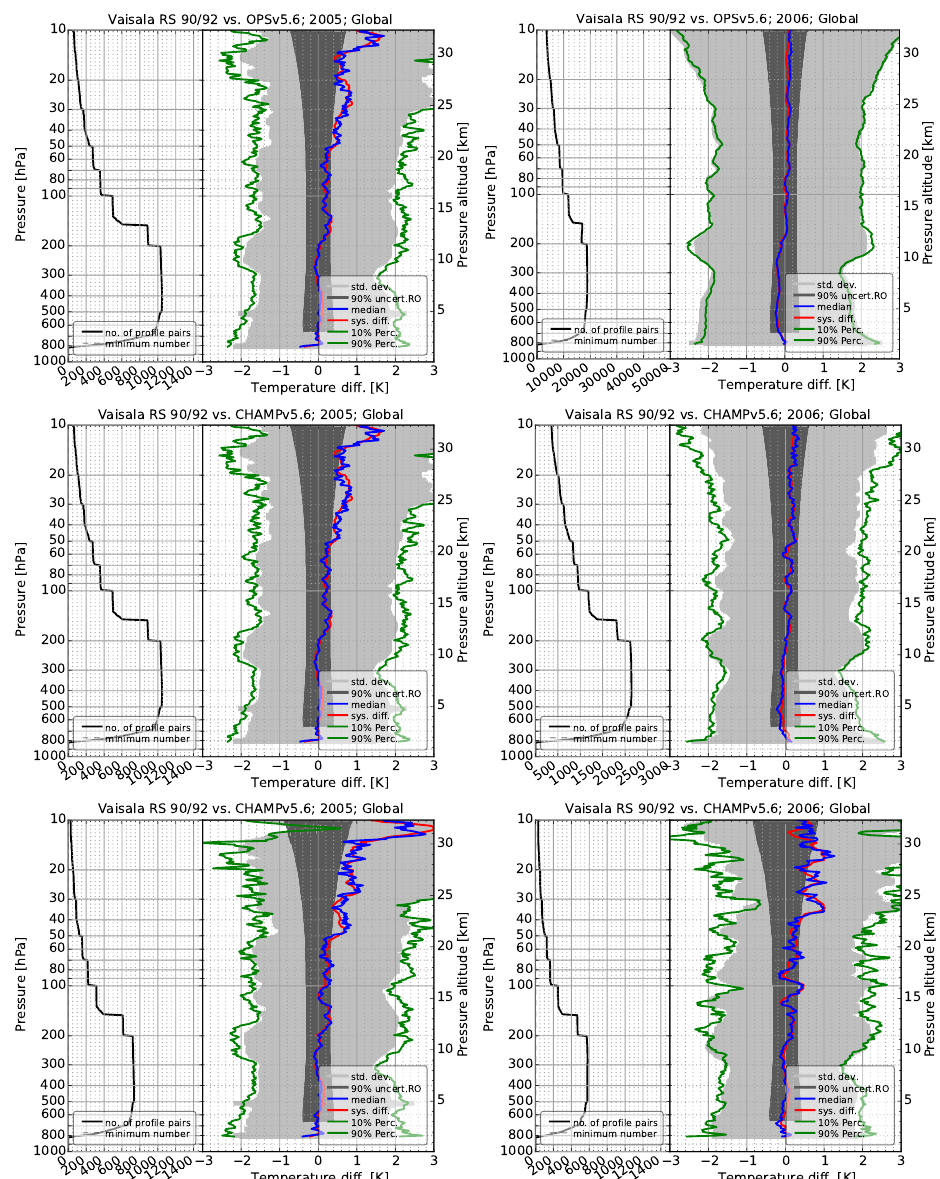
Figure 6. Global mean temperature differences as function of pressure (and pressure altitude, an approximate altitude scale also added for convenience) are shown for the years 2005 (left) and 2006 (right), for Vaisala RS90/92 data versus all GPSRO OPSv5.6 data (top), for Vaisala RS90/92 data versus CHAMP-only GPSRO data (middle), and for Vaisala RS90/92 fixed-station data versus CHAMP-only GPSRO data (bottom), respectively. The number of collocations is shown in the left subpanels.